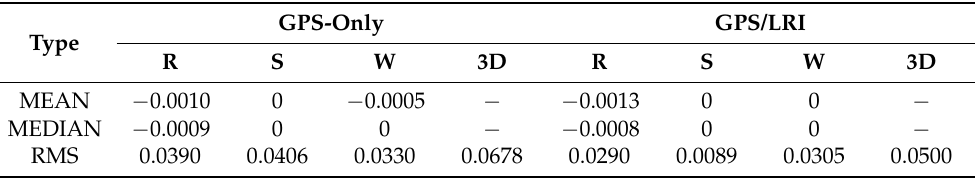
Figure 11. Days 121–242 orbit comparison residuals (in the R, S and W directions, unit: m) probability distribution for the GPS/LRI and GPS relative orbit. Table 6. Statistics of reference orbit check (days 121–242) in RSW (unit: m).